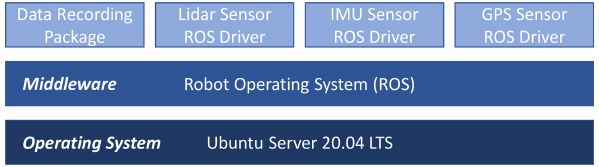
Figure 2. Software stack of the data